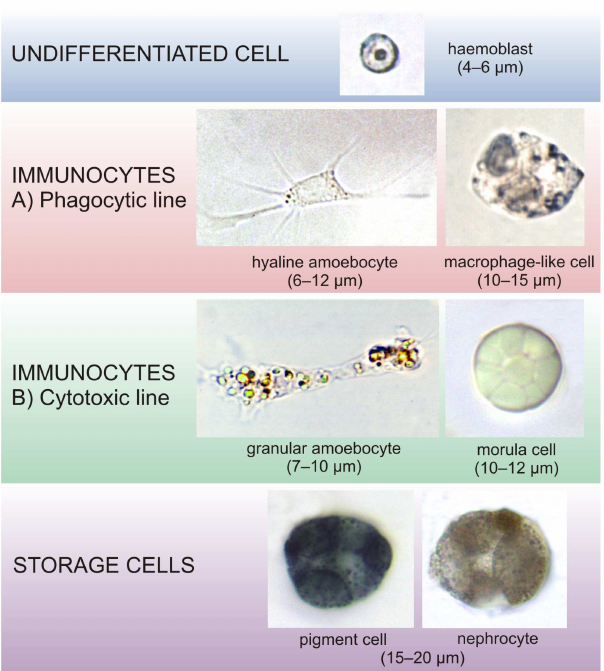
Figure 1. Classification of circulating morphotypes in the haemolymph of adult individuals (i.e., zooids) of the colonial ascidian Botryllus schlosseri . Representative living haemocytes shown with their size